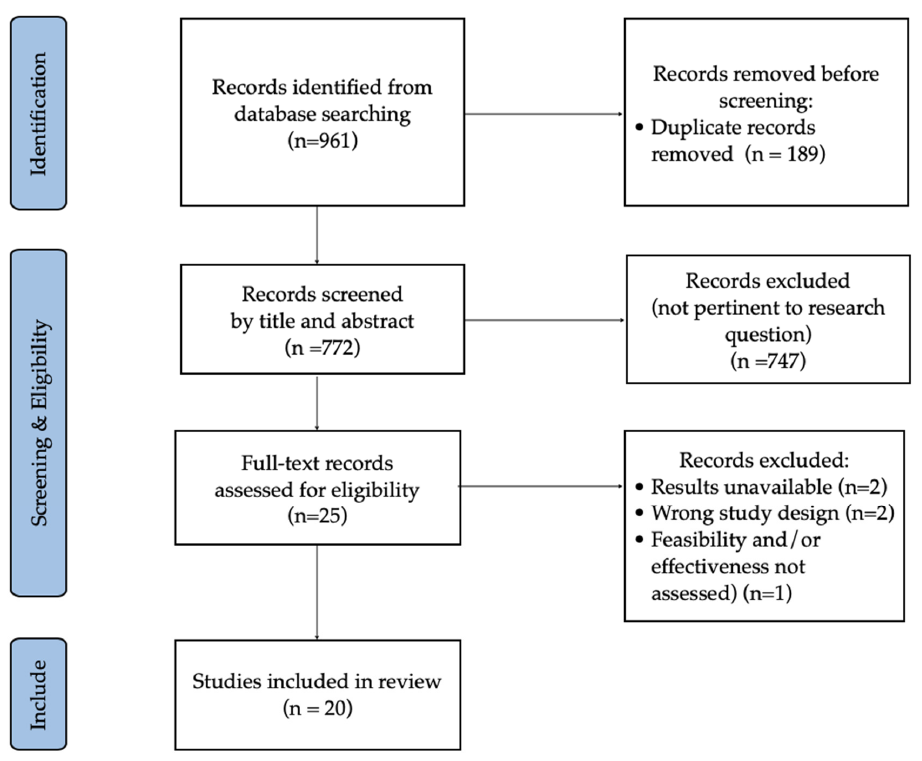
Figure 1. PRISMA flow diagram of study selection.